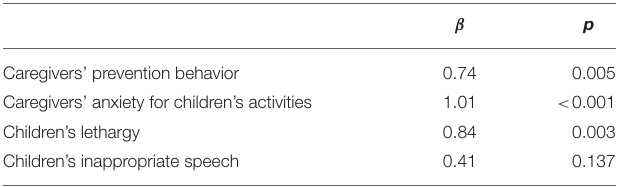
TABLE 4 | The result of the step-wise regression analysis on caregivers’ fear of COVID-19.